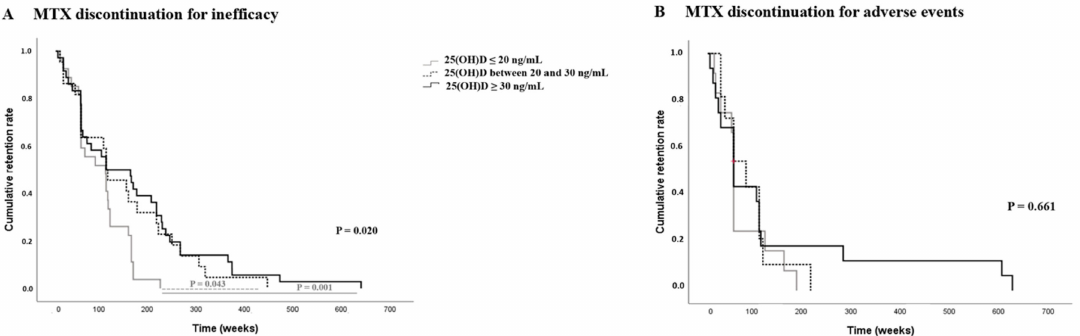
Figure 1. ( A ) and ( B ) Kaplan-Maier method. Methotrexate monotherapy survival in the groups of PsA patients with different serum level statuses of vitamin D: 25(OH)D ≤ 20 ng/mL, 25(OH)D between 20 and 30 ng/mL, and 25(OH)D ≥ 30 ng/mL. ( A ) Discontinuation of methotrexate for inefficacy. ( B ) Discontinuation of methotrexate for adverse